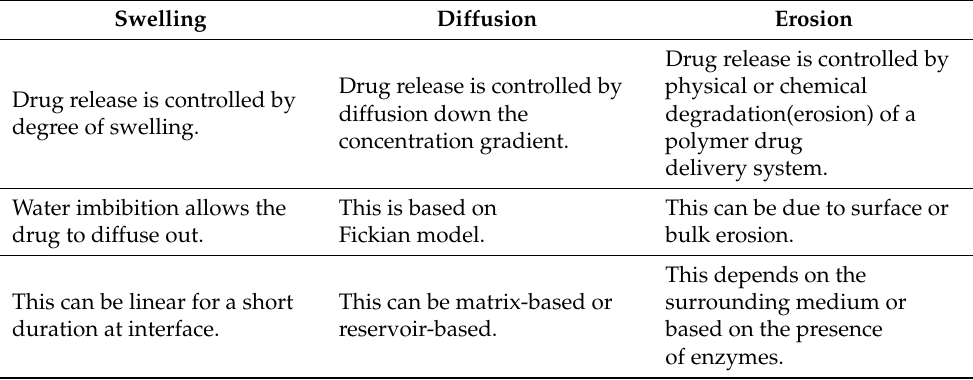
Table 2. Drug release mechanism of chitosan